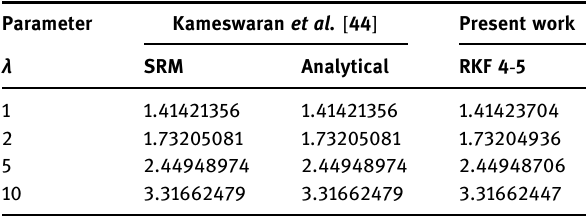
Table 4: Authentication of the problem for − f ″ ( 0 ) for various values